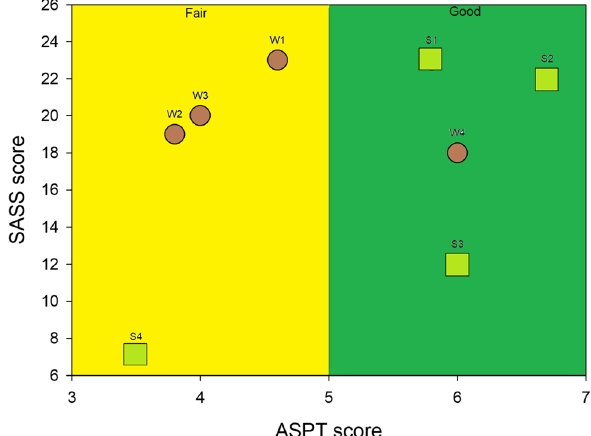
Fig. 4 Mean ASPT and SASS scores calculated for Sambandou wet- land sites over two seasons